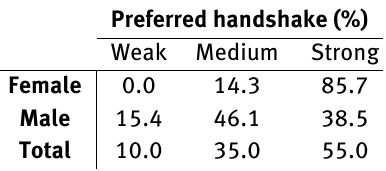
Table 2: Preferred handshake